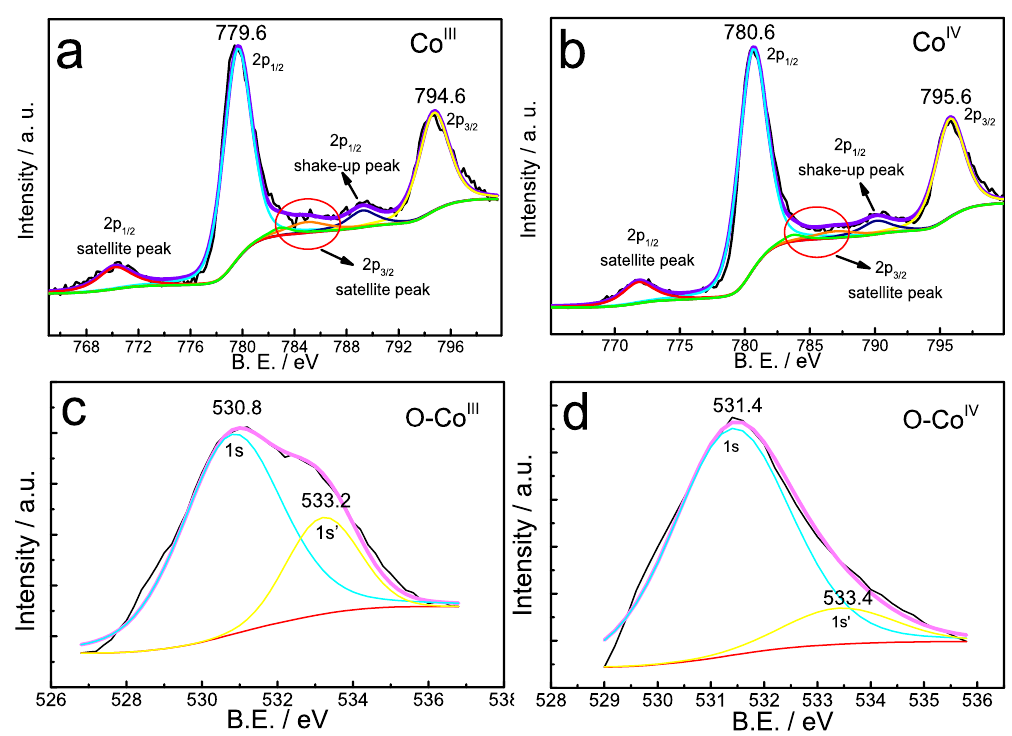
Figure 4. XPS spectra of ( a ) Co and ( c ) O at state 1 and those of ( b ) Co and ( d ) O at state 2 indicated in Fig.